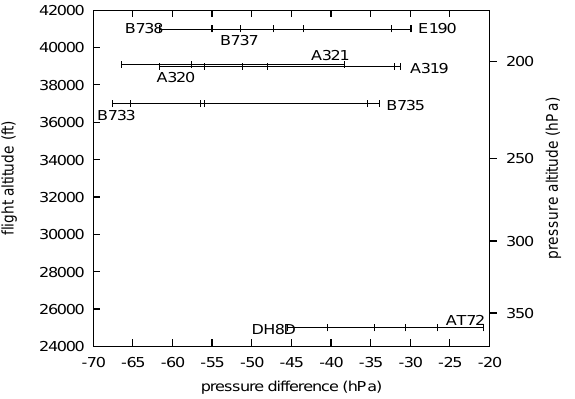
Fig. 2. Maximum temperature at which the airflow over a wing is cooled down to the supercooling limit of pure water (235 K) for three possible pressure drop values over the wing, as indicated in the legend (thick lines). The thin lines represent temperature profiles of various standard atmospheres, see legend.